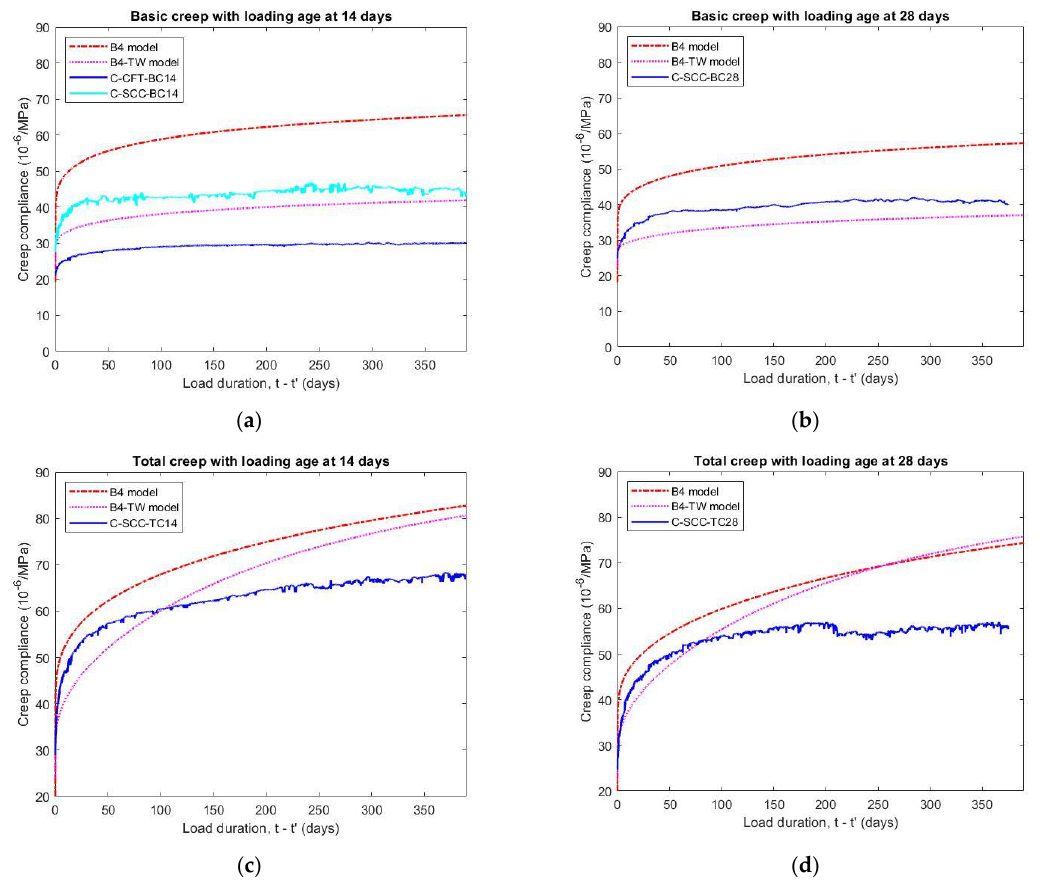
Figure 13. Comparison of experimental creep compliance and prediction models B4 and B4-TW: ( a ) basic creep loaded at 14 days, ( b ) basic creep loaded at 28 days, ( c ) total creep loaded at 14 days, ( d ) total creep loaded at 28 days.